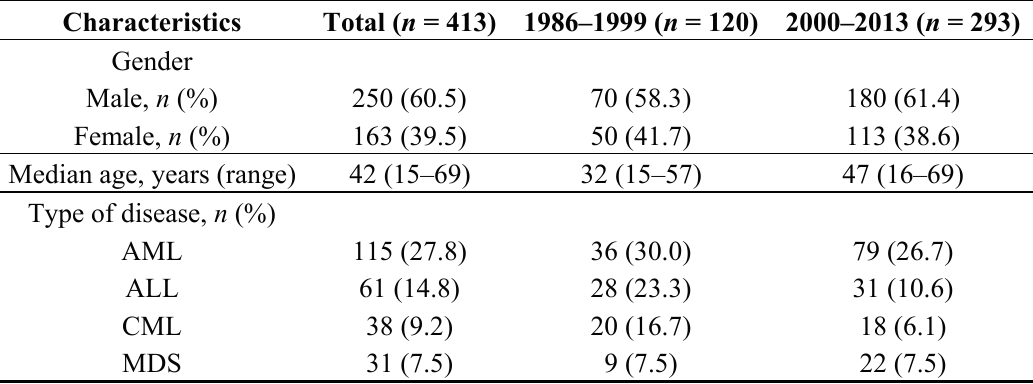
Table 4. Patient characteristics in the present